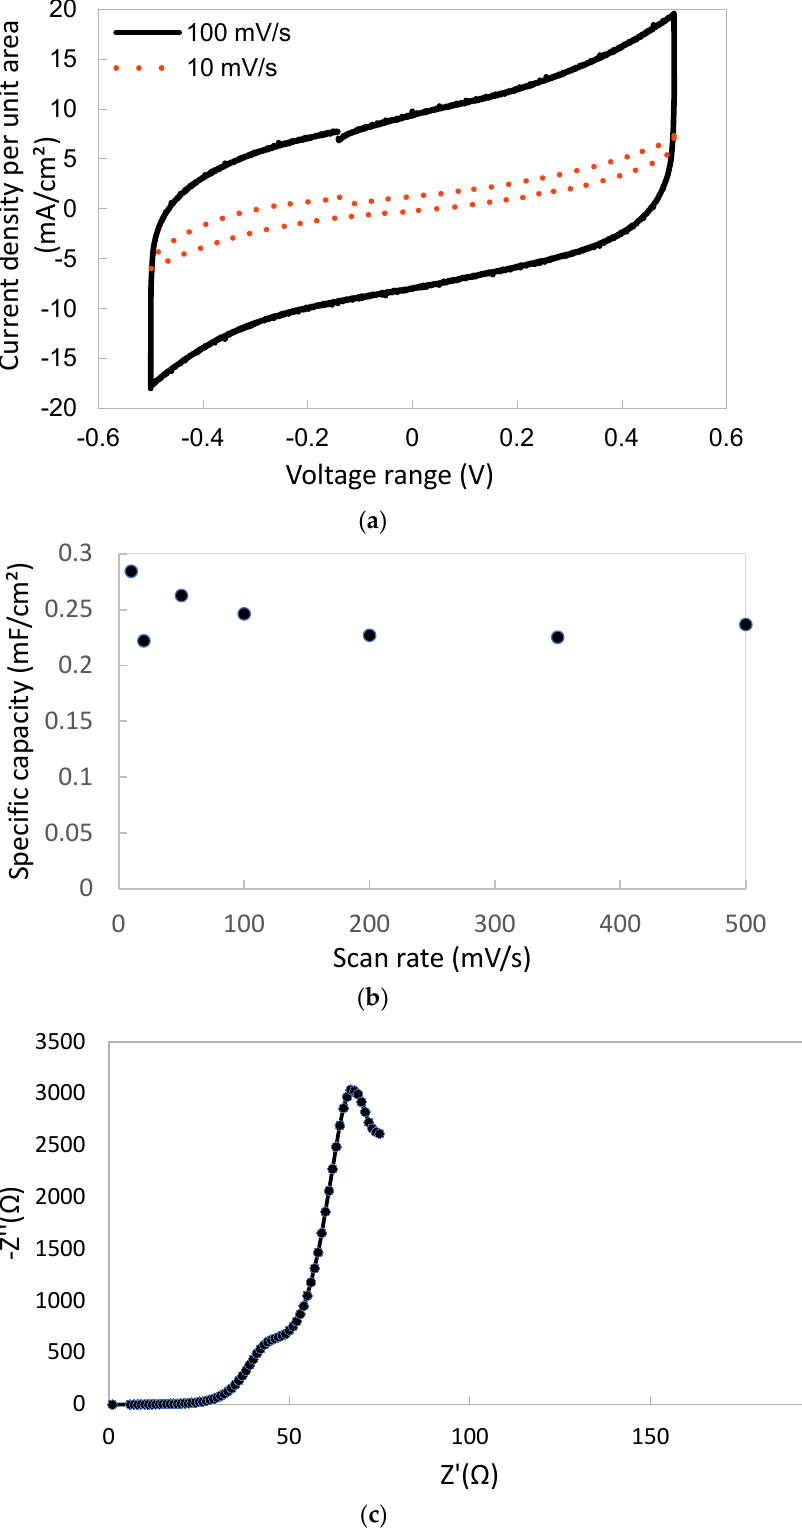
Figure 6. ( a ) Galvanostic cycling of the m-SC at a scan rate of 10 mV · s − 1 and 100 mV · s − 1 ( b ) Evolution of the specific capacitance vs. the scan rate, and ( c ) Nyquist plot.